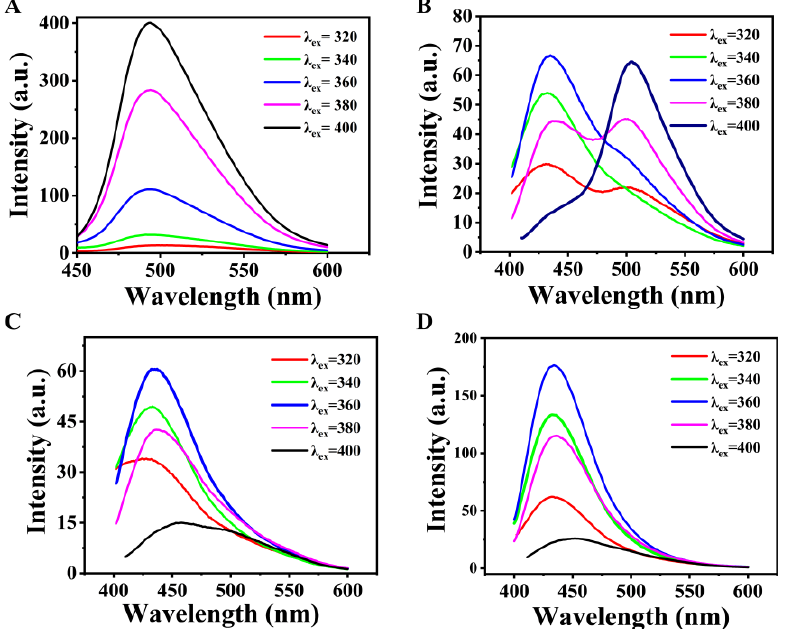
Figure 4. Fluorescence emission spectra of ( A ) 2–CDs, ( B ) 7–CDs, ( C ) 10–CDs and ( D ) 14–CDs at different excitation wavelengths.